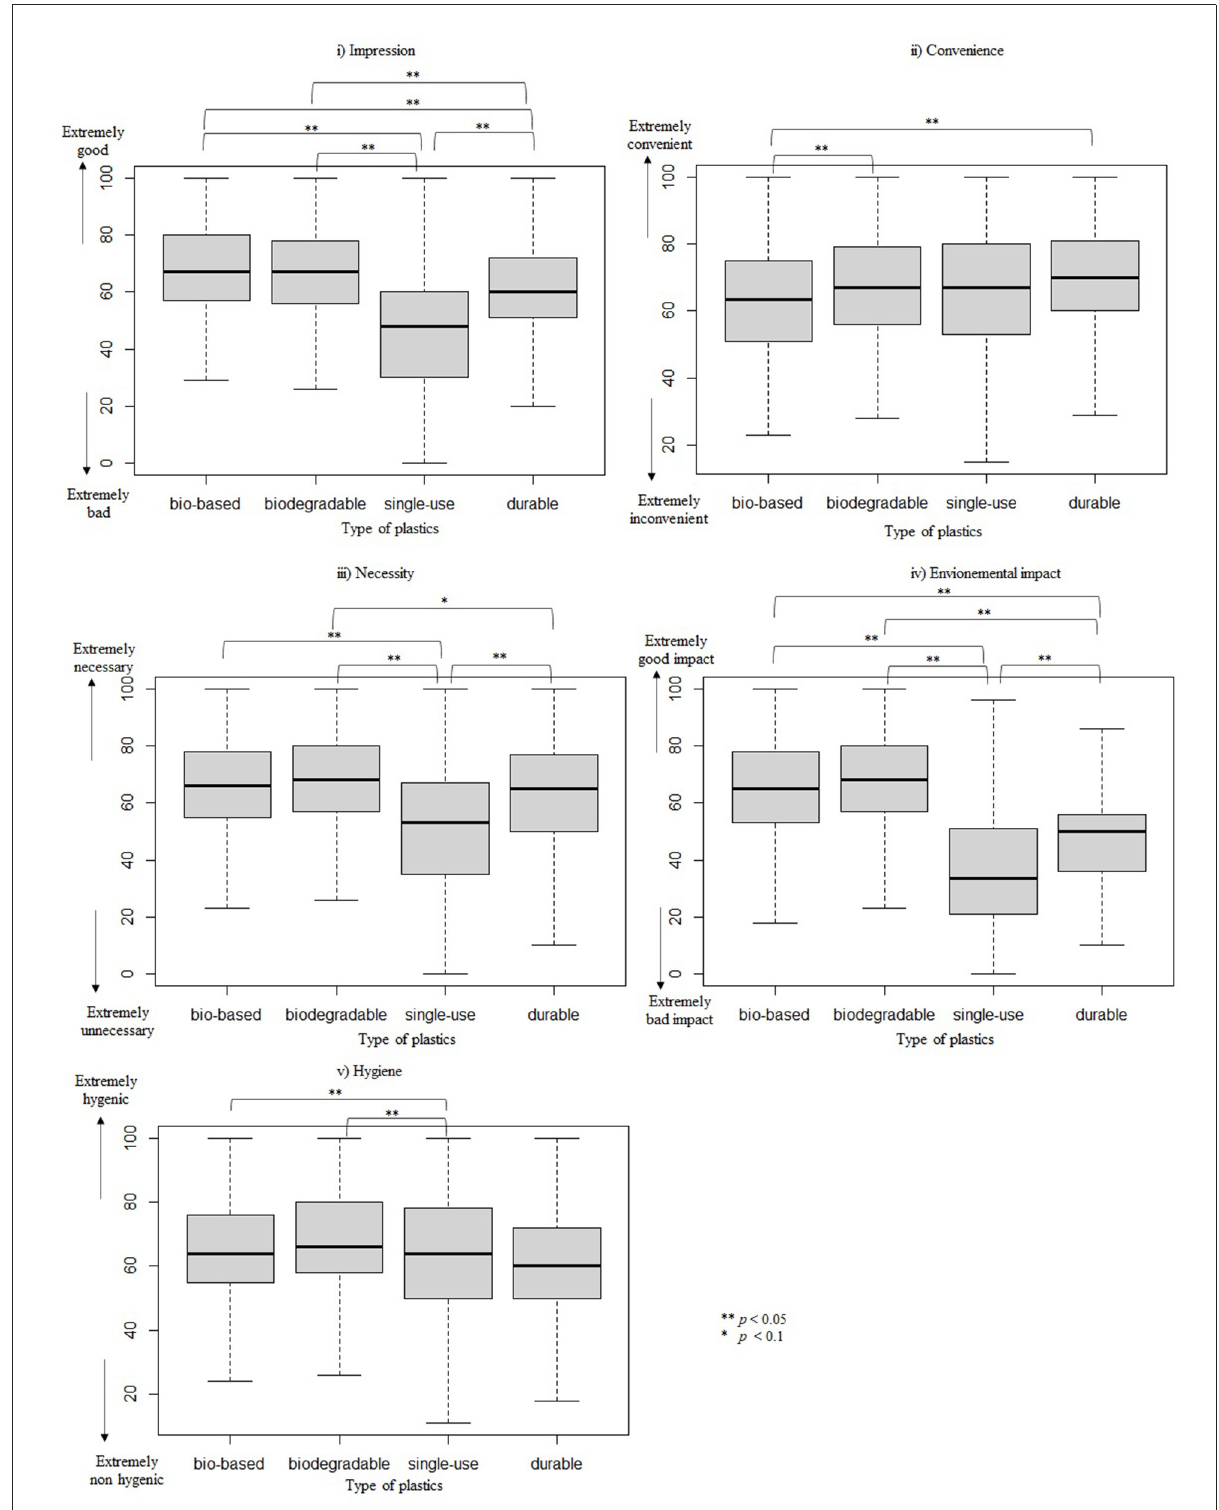
FIGURE1 Perceptions of bioplastics and conventional